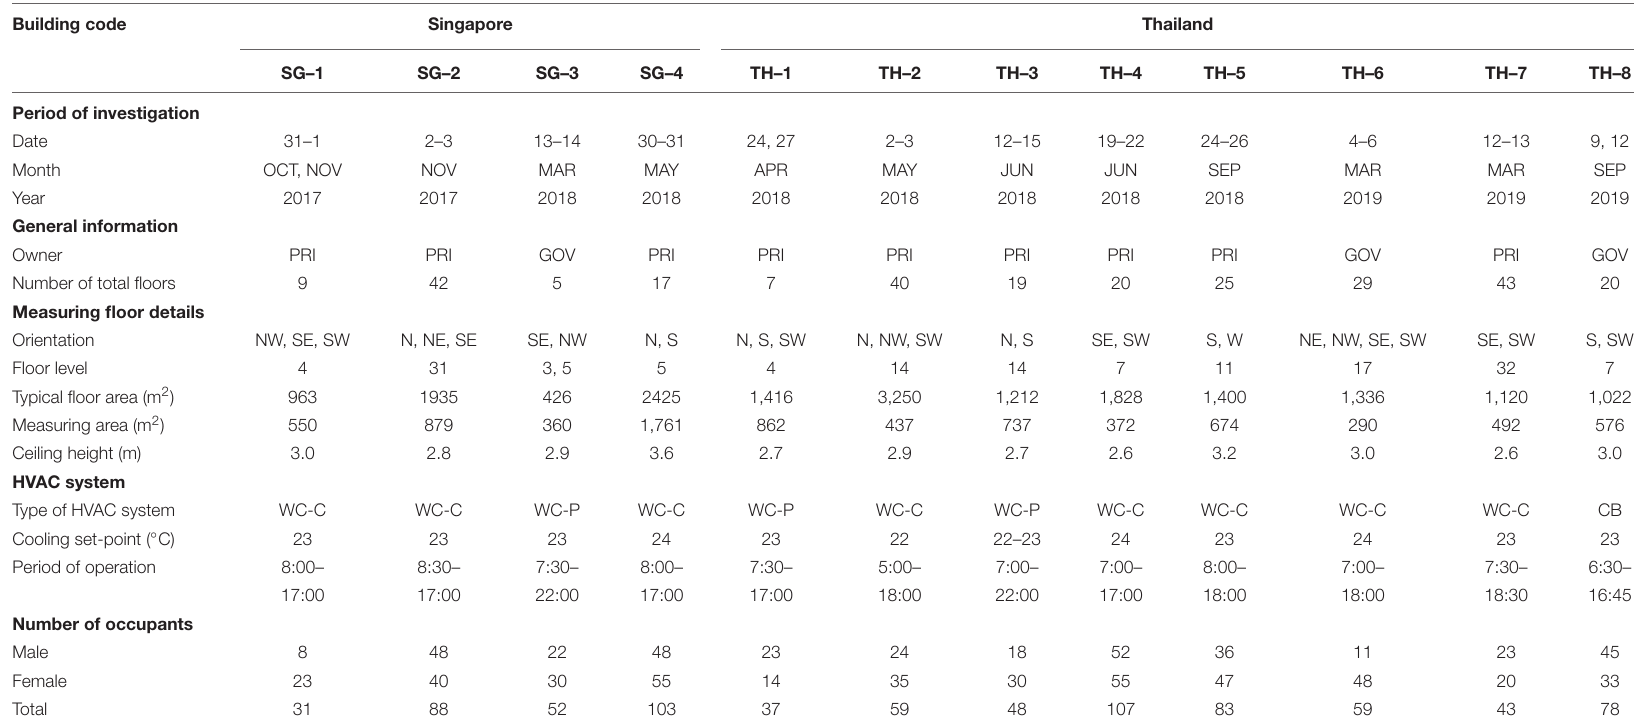
TABLE 1 | Information of the surveyed